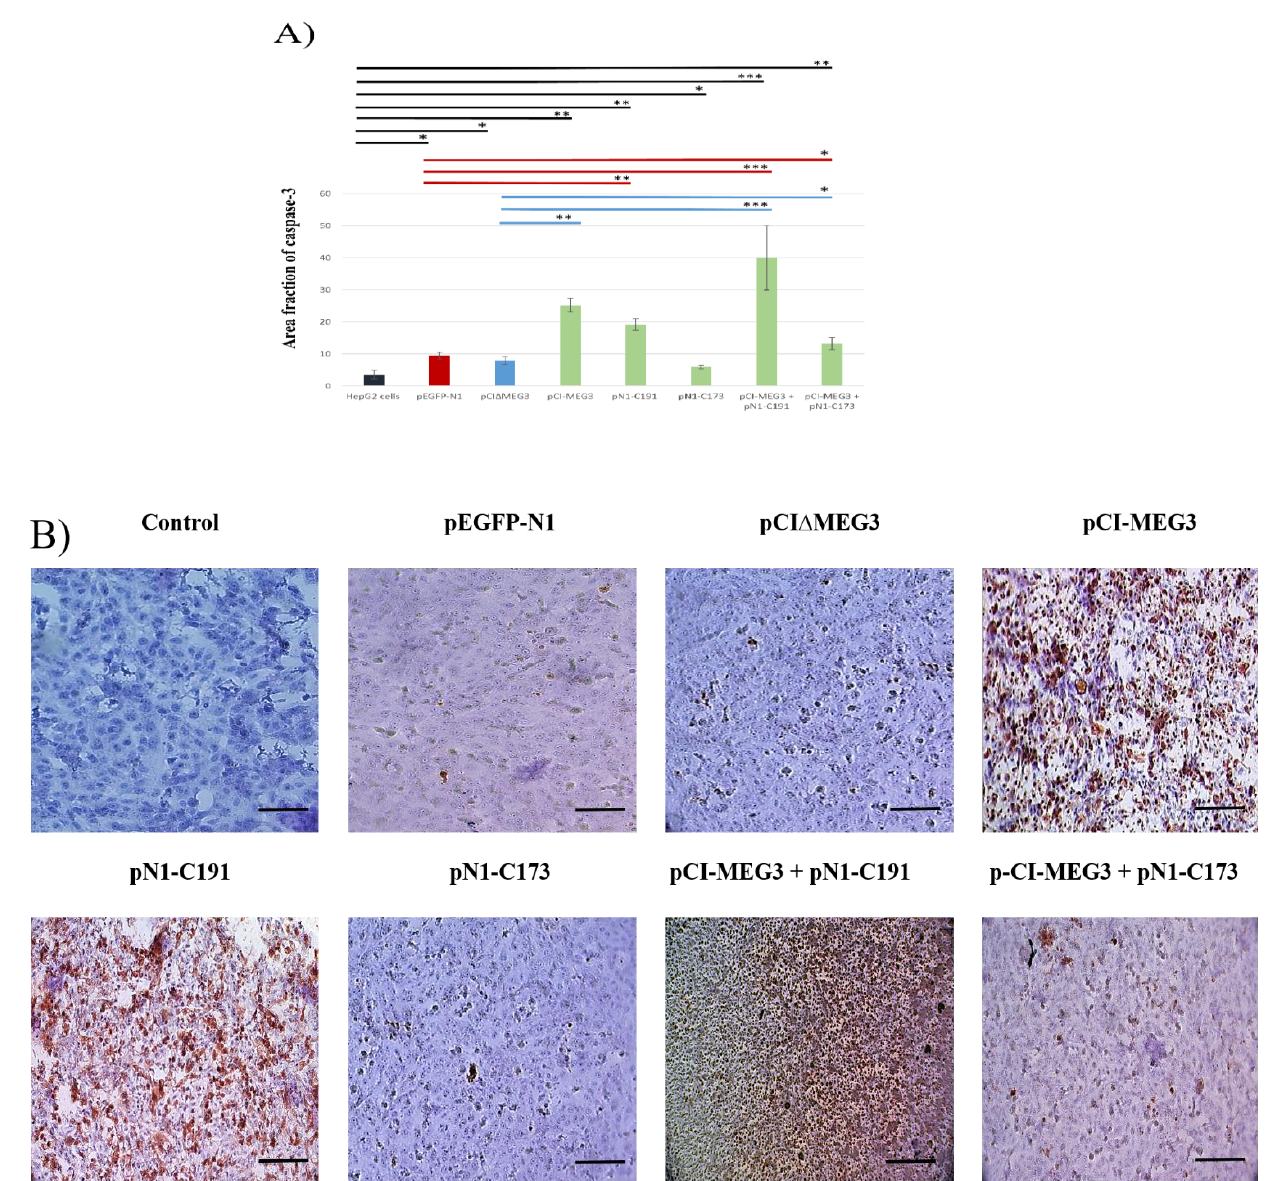
Figure 3. ( A ) Area fraction of caspase-3 expression level in HepG2 cells transfected with different plasmids. Data presented as mean ± SD. (*) shows the p -value < 0.05, (**) shows the p -value < 0.01 and (***) shows p -value < 0.001 compared to control untransfected HepG2 cells, pEGFP-N1 and pCI∆MEG3. Colored lines represent the significance of caspase-3 expression in HepG2 cells between each sample and its control. Controls are divided into (a) HepG2 cells (Black), (b) HepG2 cells transfected with pEGFP-N1 (Red), and (c) HepG2 cells transfected with pCI ∆ MEG3 (Blue). ( B ) Repre- sentative Photomicrographs of caspase-3 expression by ICC assay in transfected and co-transfected HepG2 cells with different plasmids. Scale bar 100 µ